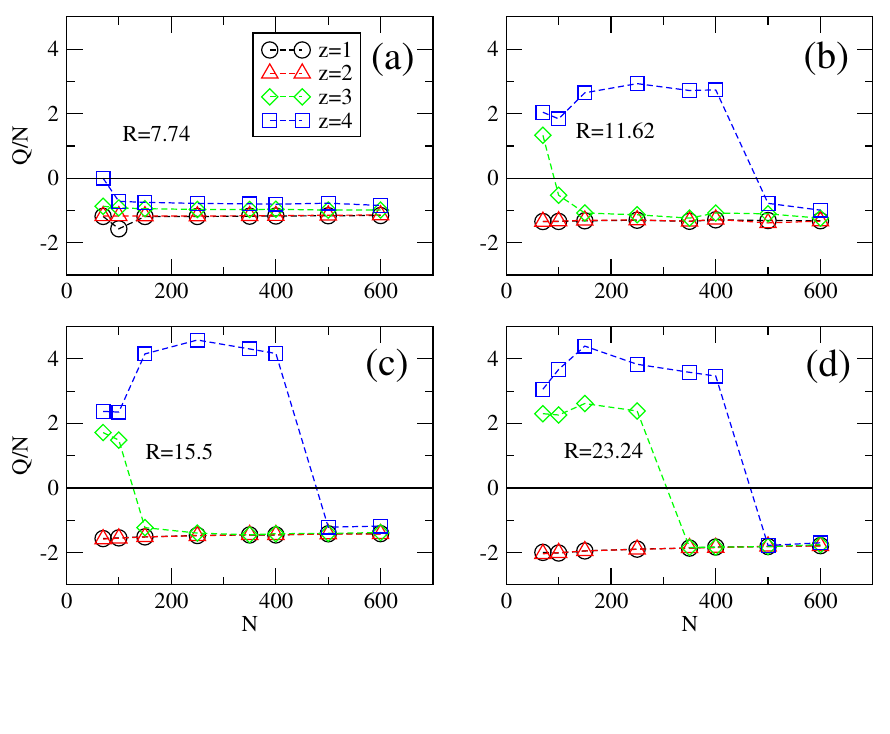
Figure 10. Graphs similar to Figures 8 and 9 of effective charge per chain length Q/N as a function of N for applied field components E radii R = 7 . 74 , 11 . 62 , 15 . 5 and 23 . 24 of the cylinder and counterion valency z . Strong E leads to an almost step function behavior of Q = Q ( N )